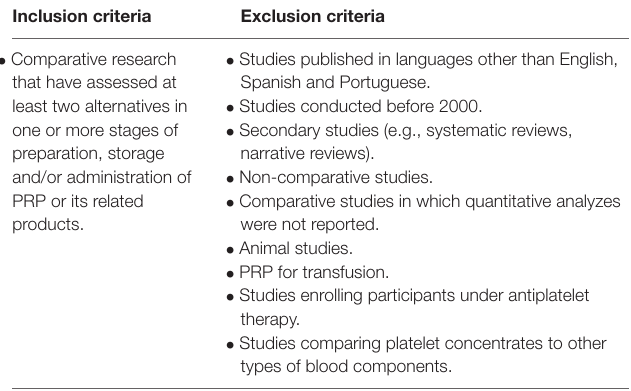
TABLE 1 | Inclusion and exclusion criteria.